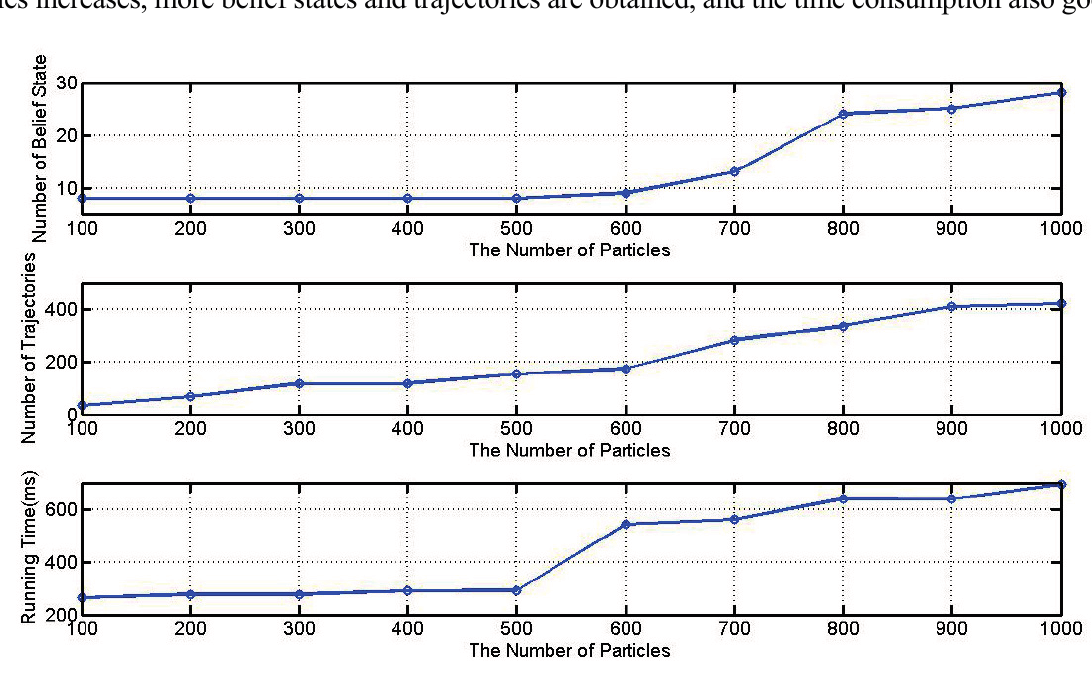
Figure 7. Effect of the number of